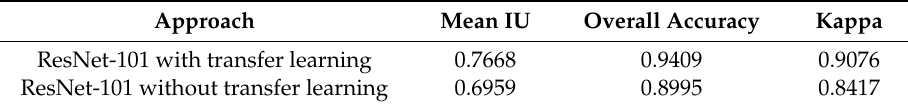
Figure 10. The training process with and without transfer learning. Table 5. Experimental results of transfer learning.